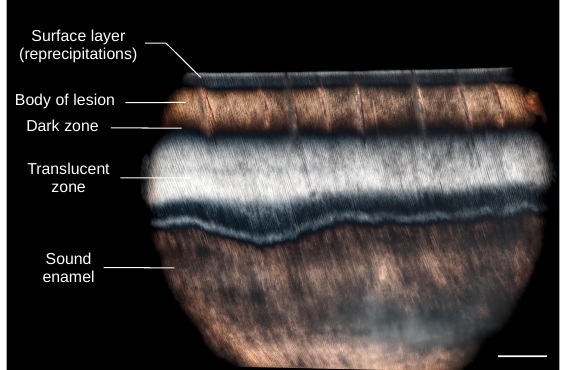
Figure 3. PLM image (40 × magnification) of an enamel slab at 25 days of demineralization with characteristic zones of lesion formation. Scale bar: 80 µm.